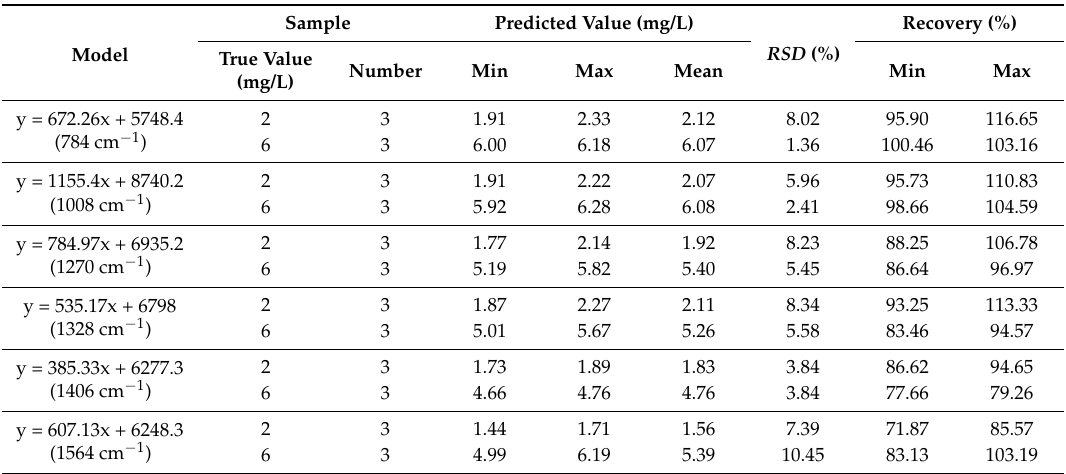
Table 3. The results between the true and predicted value of TBZ in